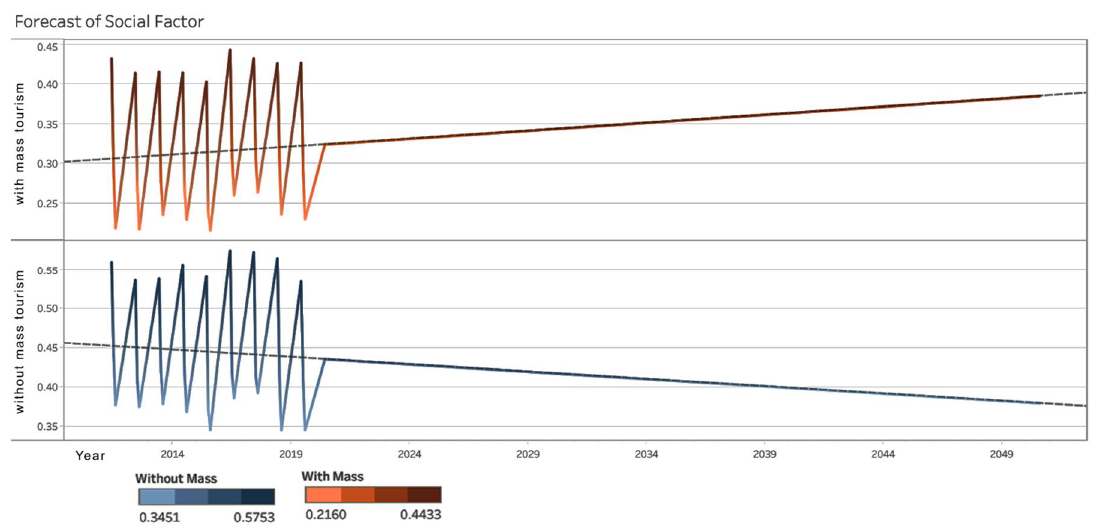
Figure 13. Analysis of social factor average indicators for the two scenarios.